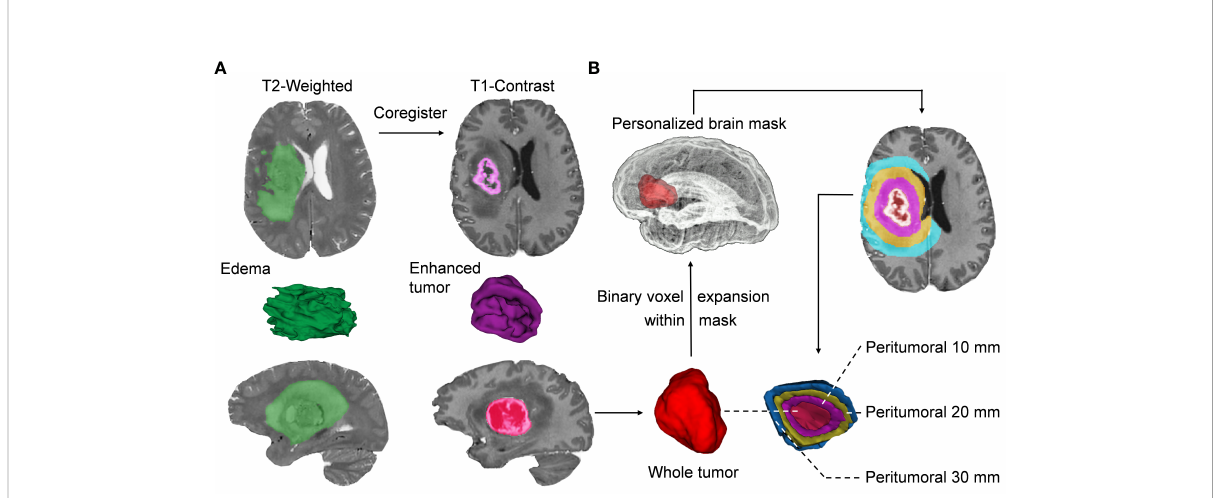
FIGURE 2 Segmentation of the intratumoral and peritumoral subregions. (A) After image preprocessing, the visible tumors were segmented into different subregions, including enhancement, whole tumor, and edema, based on a semi-automatic threshold and seed-growing algorithm. (B) The same approach was used to segment individualized brain masks without ventricle, cortical sulci, and infratentorial structures. The morphological binary expansion of the whole tumor is performed to delineate the peritumoral brain zone (PBZ) regions, which are con fi ned within the individualized whole-brain mask. In each iteration of voxel dilation, a 1-mm 3 ring around the enhanced lesions will be obtained, and the iterations eventually reach a radial distance of 30 mm. Then, the distance quantitative PBZ regions of interest (ROIs) are obtained by subtraction calculation of the tumor mask. The purple, yellow, and blue ROIs represent the generated ROIs at 10, 20, and 30 mm from the border of the enhanced tumor,